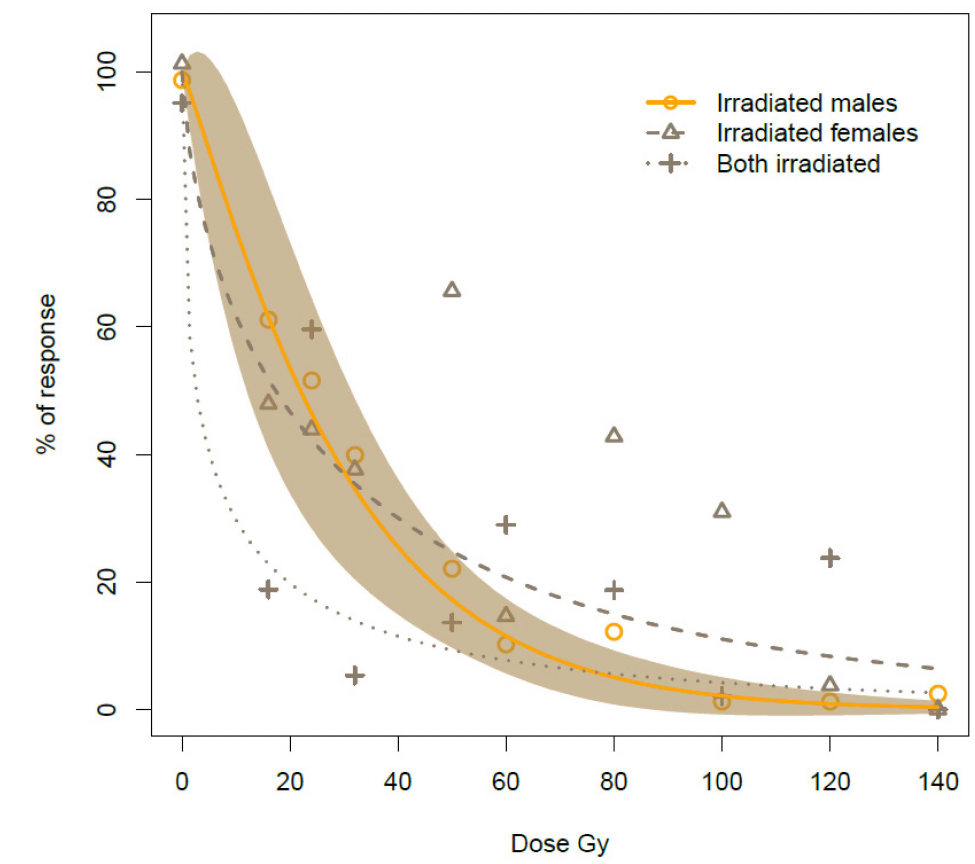
Figure 2. Weibull-1 curves ( c parameter set to 0) calculated for the percentage of the response of egg eclosion for the three tested crosses ( irradiated males × fertile females; irradiated females × fertile males; both irradiated ). The 95% CI is shown only in the case of the irradiated males x fertile females curve, for